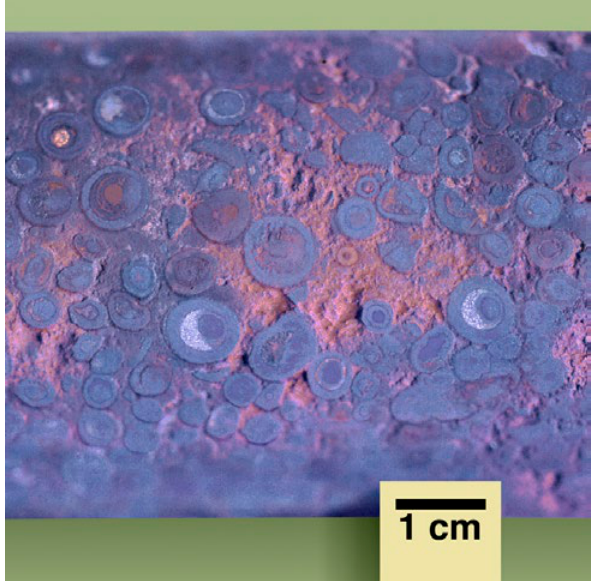
Figure 13. Fish-egg sized concretions or oolites were found in the quartz-magnetite lode at Peko Mine, Tennant Creek.